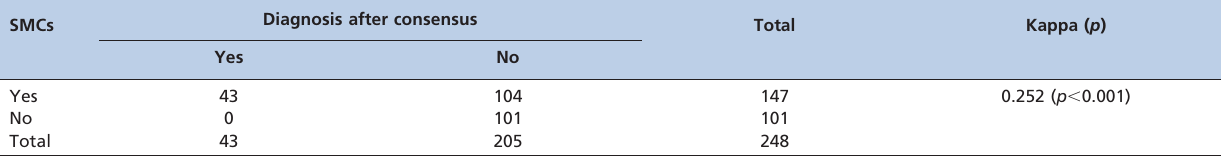
Table 2 - Distribution of subjective memory complaints according to diagnosis after consensus.